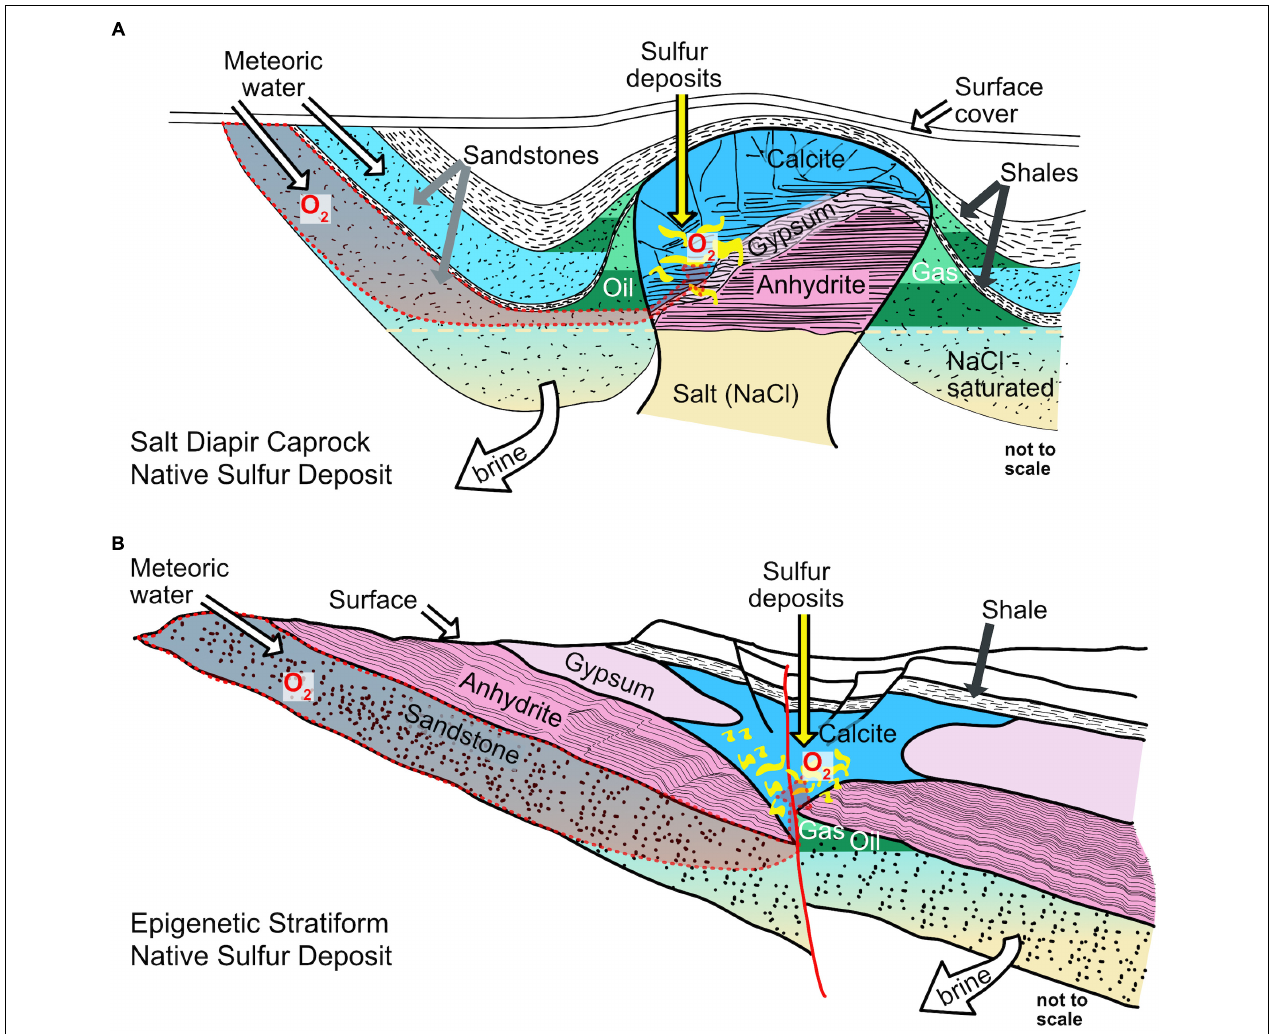
FIGURE 1 | Sketches of classical epigenetic salt diapir caprock and stratabound sulfur deposit types. (A) Oxygen is delivered to the site where native sulfur is formed by infiltration of meteoric water. On its journey to the location where native sulfur is formed, O 2 has to pass hydrocarbon bearing strata. Solubility of O 2 may decrease with depth due to increased salinity. To maintain inflow of meteoric waters, the brine must be removed (modified from Ruckmick et al., 1979). (B) Oxygen is delivered to the site where native sulfur is formed by infiltration of meteoric water. On its journey to the location where native sulfur is formed, O 2 takes the same route as the hydrocarbons. Solubility of O 2 may decrease with depth due to increased salinity. To maintain inflow of meteoric waters, the brine must be removed (modified from Ruckmick et al.,